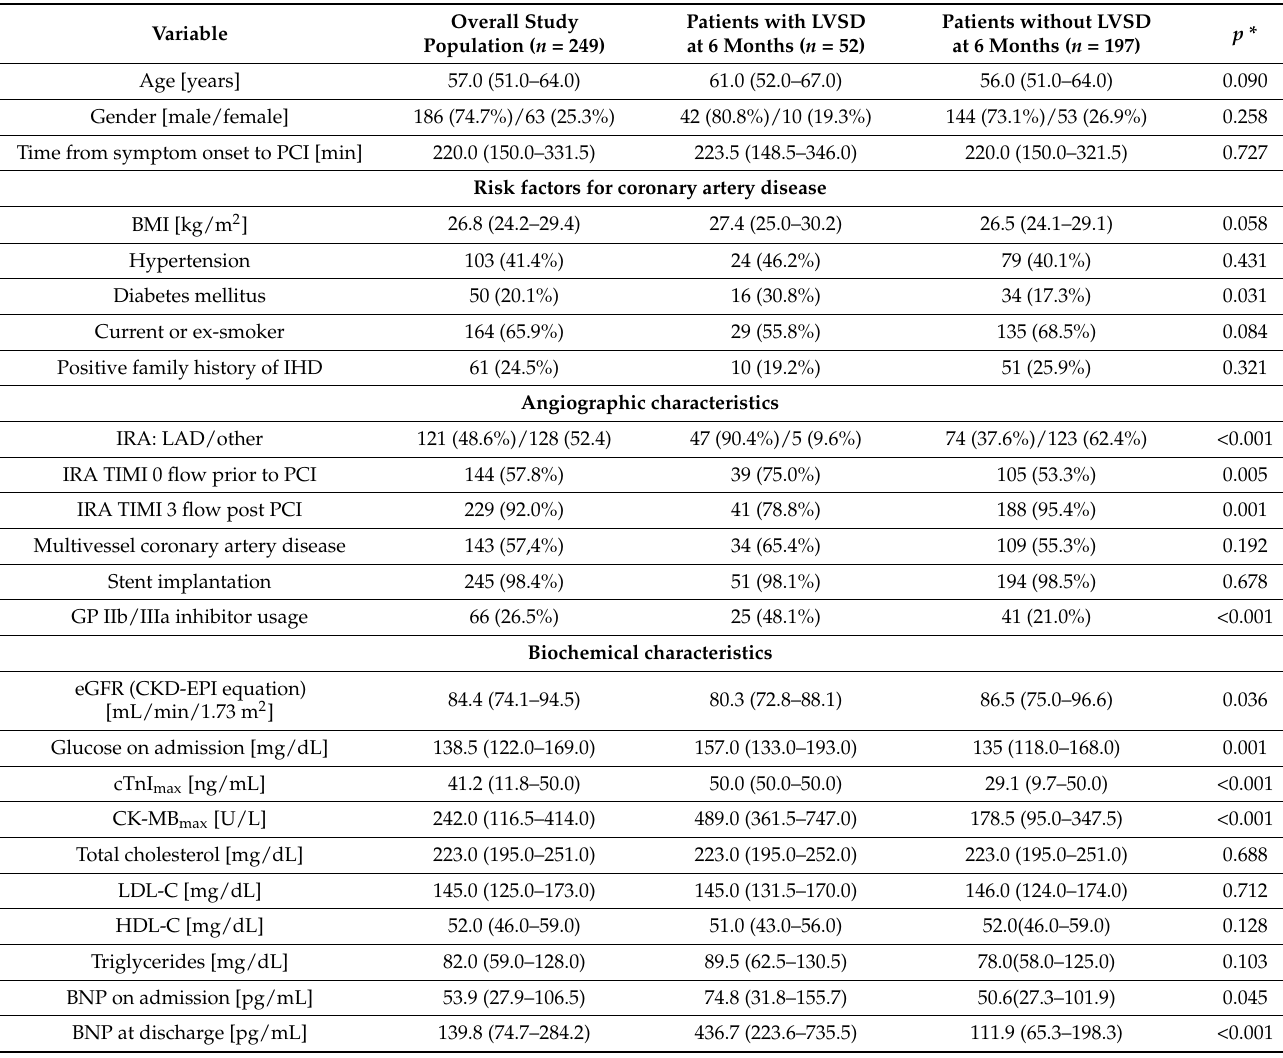
Table 1. Clinical characteristics of the study population in relation to the occurrence of LVSD. Data are presented as median (lower quartile-upper quartile) or number (percent) when